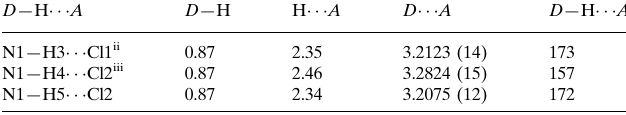
Hydrogen-bond geometry (A˚ , (cid:2)